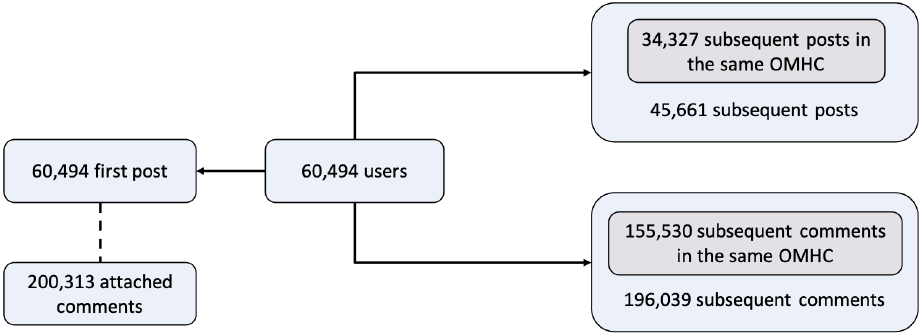
Figure 1. Statistics of the collected OMHC dataset. The “subsequent posts/comments in the same OMHC” means the posts/comments that users published subsequently in the same OMHC as their first